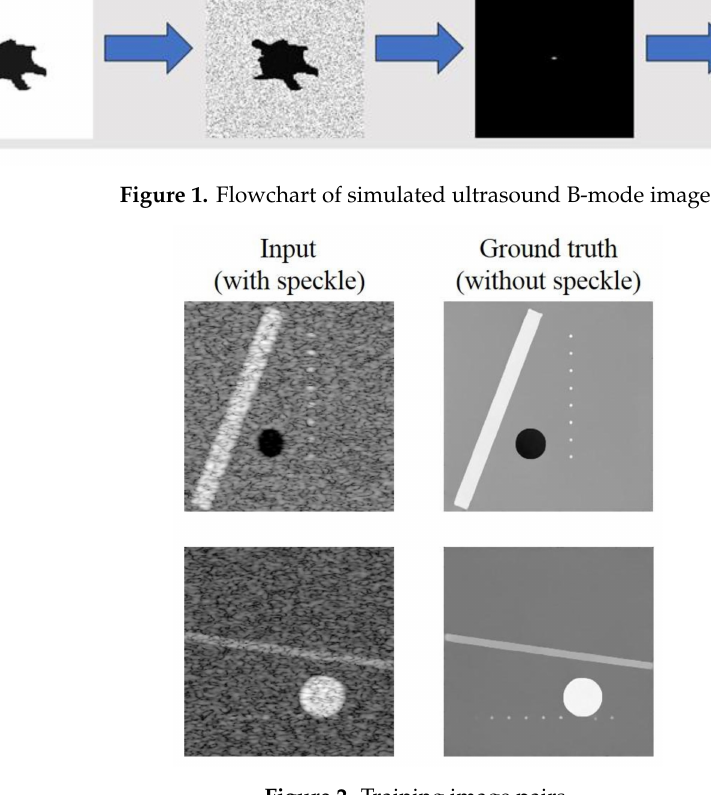
Figure 2. Training image